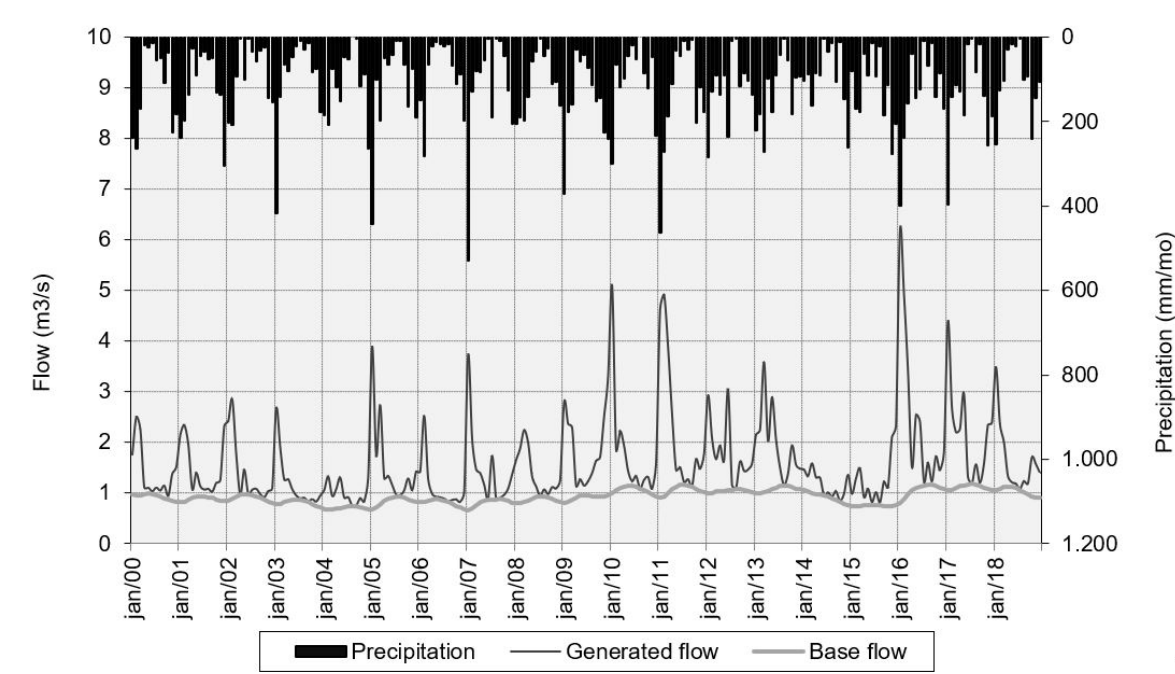
Figure 5. Hydrograph of average monthly flows generated according to the SMAP model - Batalha River, from January 2000 to December 2018 and the base flow calculated from the Eckhardt Flow Separation